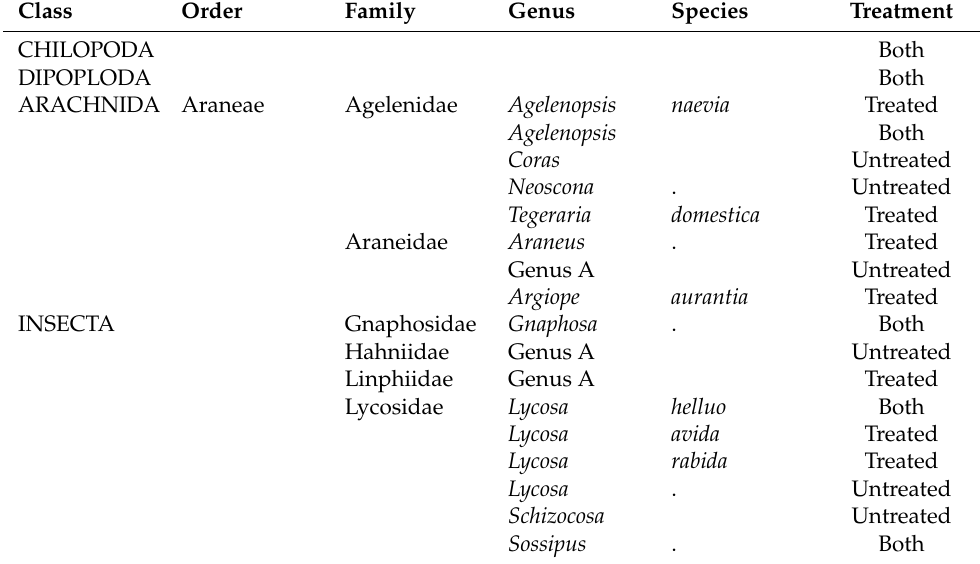
Table 1. Invertebrates collected from all sites using a burrow vacuum for six sampling periods (1 pre-treatment, 5 post-treatment). If possible, specimens were identified to genus and species. “Treated” refers to species found only on sites treated to reduce fire ant populations, “untreated” refers to species found only on untreated sites, and “both” refers to species found on both treated and untreated sites. Species annotated with an “*” were considered “commensal”